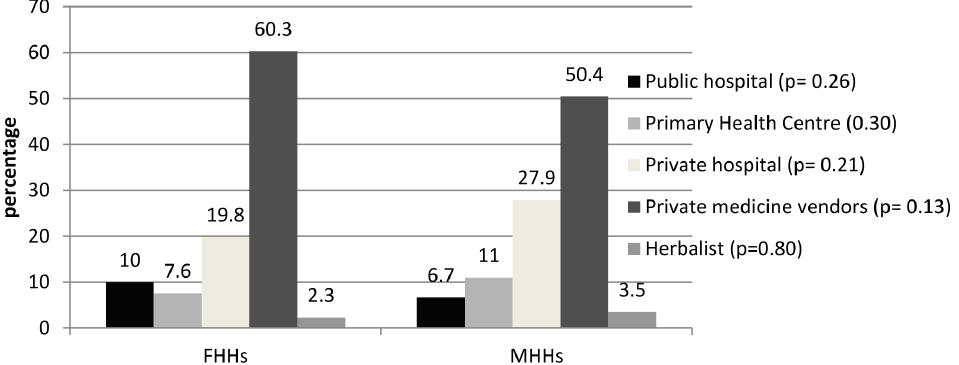
Figure 1. Type of health care provider utilized.